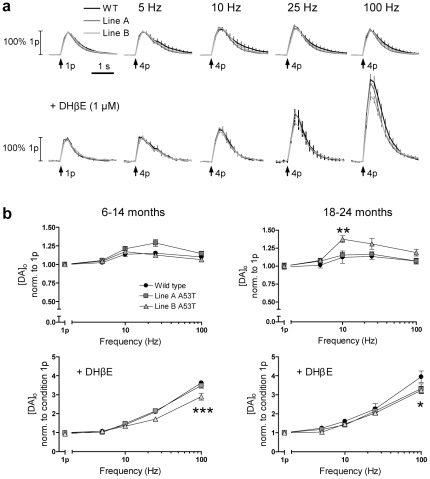
A53Tα-syn overexpression causes subtle deficits in DA release in response to high versus low frequency stimulation, when nAChRs are inhibited.(a) Profiles of mean [DA]o± SEM versus time, evoked by 4-pulse stimulation (1–100 Hz), with intact nAChR activity (upper), and with nAChR inhibition (DHβE, 1 µM) (lower)(6–14 months only shown). (b) Mean peak [DA]o±SEM evoked by 4-pulse stimulation (1–100 Hz), normalised to single pulse release, with nAChR activity (upper) and with nAChR inhibition (in DHβE, 1 µM)(lower). With intact nAChR activity, there was no significant difference in frequency response between genotypes at 6–14 months (n = 9–15). At 18–24 months, normalised peak [DA]o evoked by 10 Hz stimulation was slightly greater in line B versus WT (2-way ANOVA, post hoc Bonferroni t tests, p<0.05; n = 9–15). With nAChR inhibition, in DHβE, at 6–14 months, normalised peak [DA]o evoked by 100 Hz stimulation was significantly lower in line B than WT (2-way ANOVA, post hoc Bonferroni t test, p<0.001; n = 9–15) and, at 18–24 months, normalised peak [DA]o evoked by 100 Hz stimulation was significantly lower in both A53Tα-syn overexpressing lines compared to WT (2-way ANOVA, post hoc Bonferroni t test, p<0.05; n = 9–15).